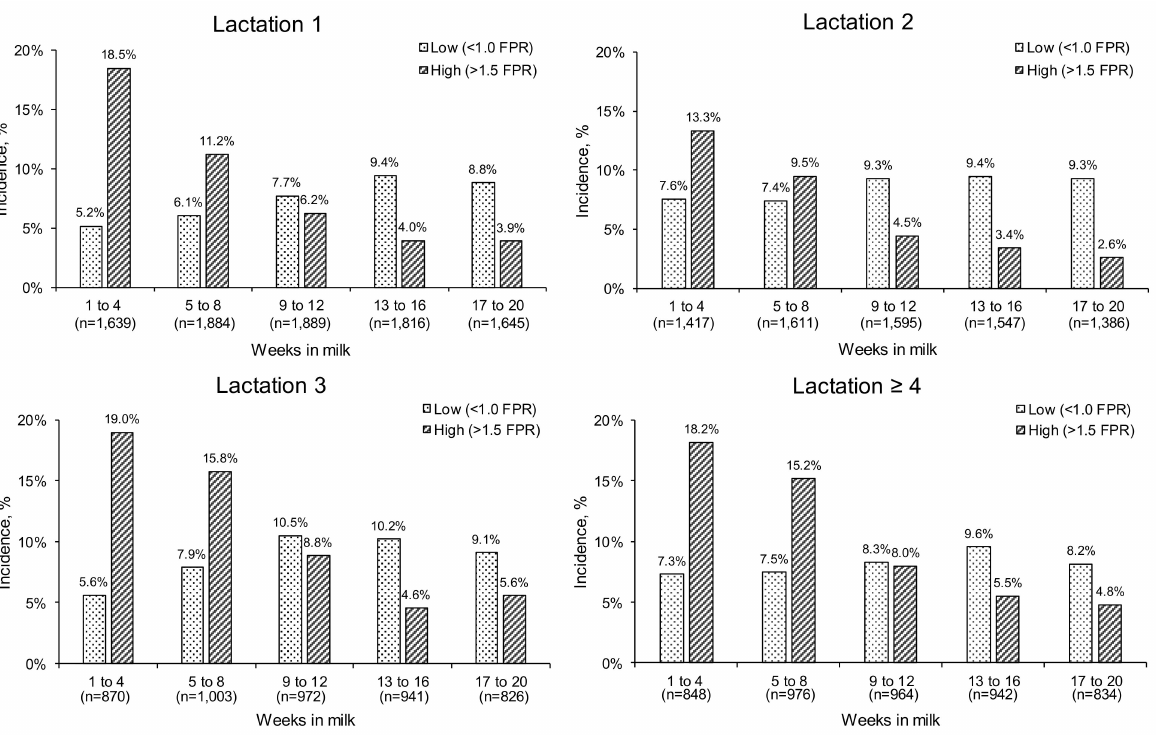
Figure 5. Incidence of extreme fat-to-protein ratio scores in milk (FPR scores: <1.0 = ‘Low’, and >1.5 = ‘High’) across lactations (1, 2, 3, and ≥ 4) at specific at four WIM intervals in early lactation dairy cows (1–20 WIM). The number of observations ( n ) include ‘Normal’ values (1.0–1.5 FPR). Table 4. Performance indicators and blood metabolites (adjusted least squares means: 4 wk intervals) of first lactation Holstein-Friesian dairy cows within three fat-to-protein ratio scores in milk during early lactation (1–20 WIM). WIM/Item